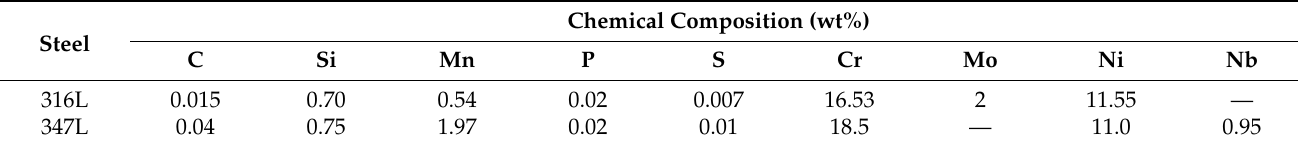
Table 1. Chemical composition of stainless steel (wt%).